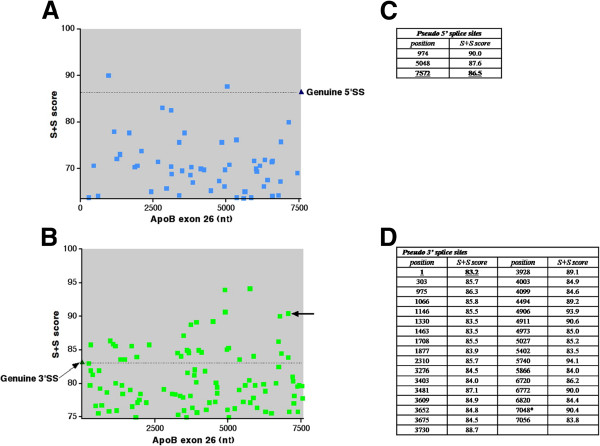
Shapiro and Senapathy [[4]] scores for pseudo splice sites scoring higher than the lowest-scoring genuine APOB splice sites. The dotted lines show the scores of the genuine splice sites flanking exon 26. (A) Scores of 5′ splice sites (ordinate) plotted against position in exon 26 (abscissa). (B) Scores of 3′ splice sites (ordinate) plotted against position of the in exon 26 (abscissa). The arrow indicates the pseudo splice site that is used in the alternative splicing event identified in Figure 6. (C) Table of positions and Shapiro and Senapathy scores of pseudo 5′ splice sites in exon 26 scoring higher than the native 5′ splice site at position 7572. (D) Table of positions and Shapiro and Senapathy scores of pseudo 3′ splice sites in exon 26 scoring higher than the native 3′ splice site at position 1. The asterisk indicates the pseudo splice site that is used in the alternative splicing event identified in Figure 6.